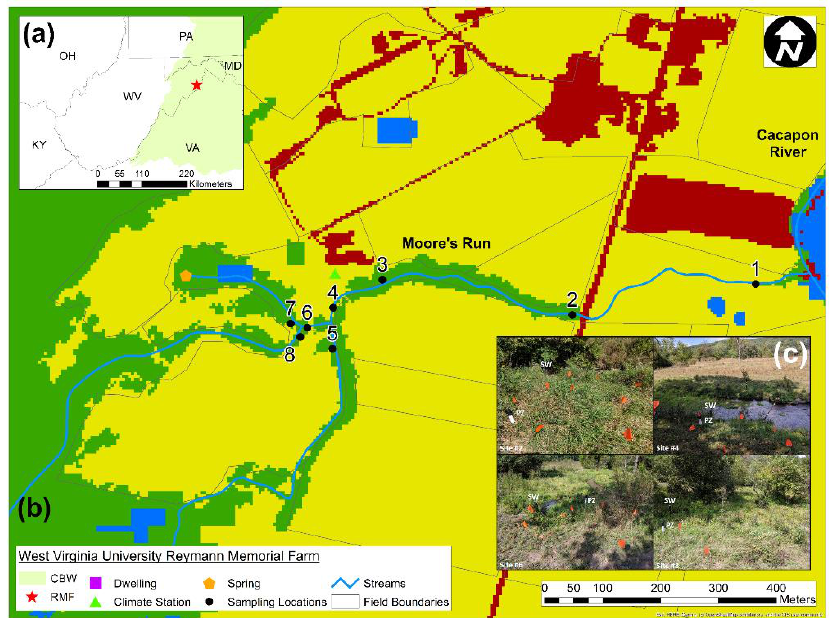
Figure 1. ( a ) The location of Reymann Memorial Farm (RMF) within the upper Chesapeake Bay Watershed (CBW), ( b ) the locations of eight co-located, nested stilling wells and piezometers throughout Moore’s Run Watershed, Wardensville, WV, USA with the land use/land cover for the study area, where red, mixed development; yellow, agriculture; green, forested; and blue, open water, and ( c ) images of four sites, where SW, stilling well, and PZ, piezometer. The orange flags denote soil core sample locations from [41].